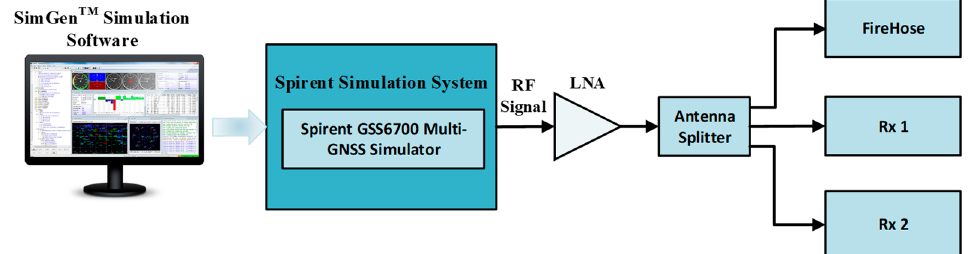
Figure 6. Schematic Diagram of the Hardware System.